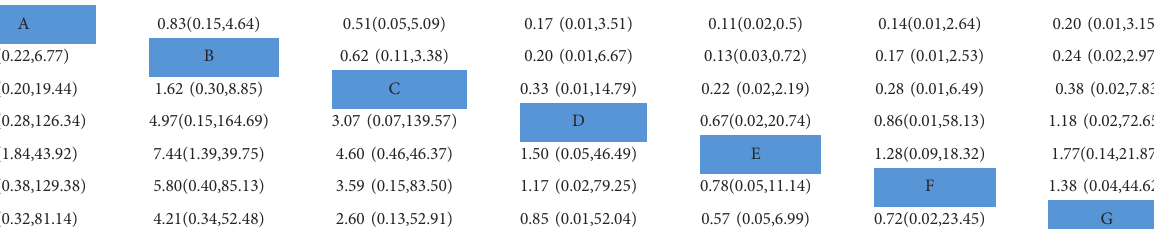
TABLE 2 Head-to-head comparisons of ef fi cacy of